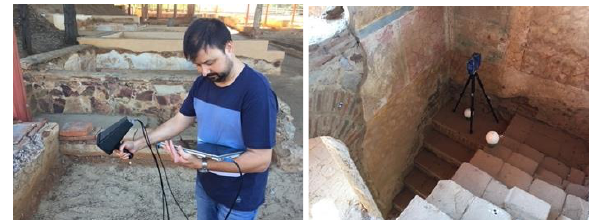
Figure 2. Data acquisition in the “Casa del Mitreo”: Data acquisition using the proposed prototype (left); Laser scanning capture process using Faro Focus X330 (right).